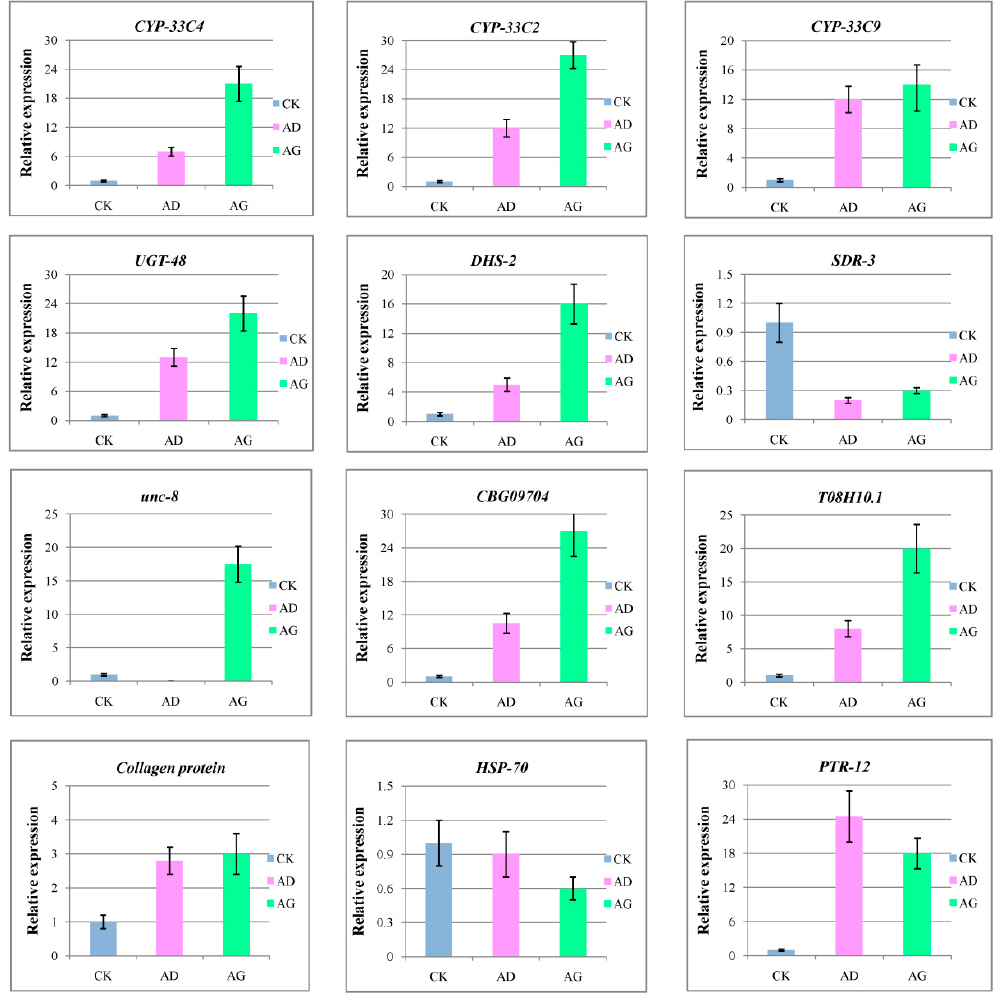
Figure 6. qRT-PCR validation of key candidate DEGs in the AD and AG samples. The CK sample served as the control. Data from the qRT-PCR represent the mean of three replicates, and bars represent standard error.